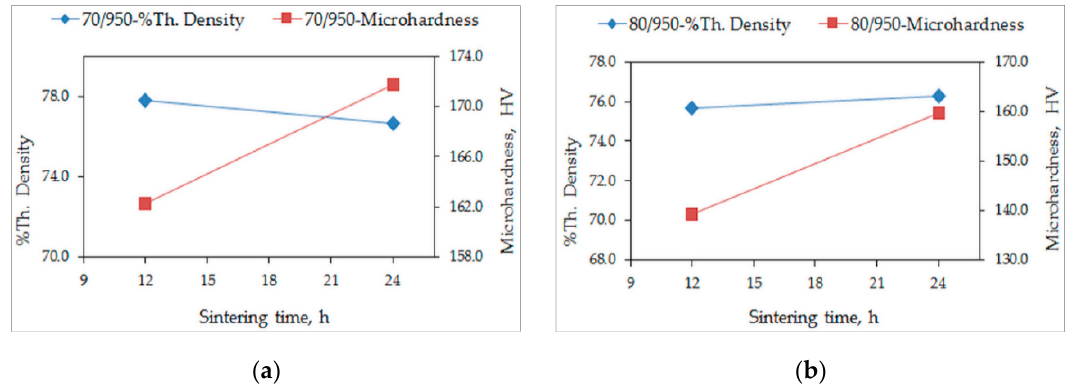
Figure 1. Variation of % theoretical density and microhardness with sintering time of: ( a ) S950a1, S950a2; ( b ) S950b1, S950b2.